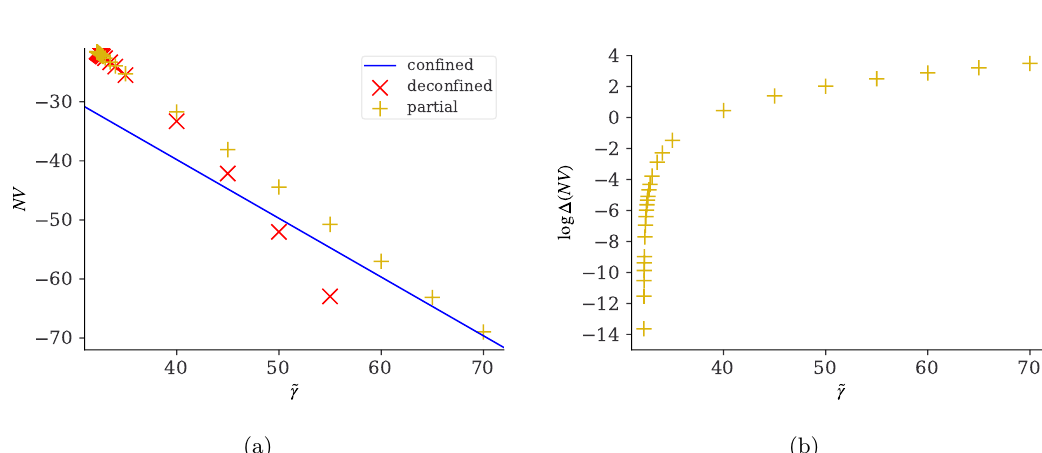
Figure 9. (a) θ = π numerical results for the | M j | versus j for N = 30 in the partial phase, for ˜ γ = 45 (red crosses) and 70 (black 3-point stars). Notice that | M 0 | is small but non-zero. (b) Using eq. (2.23), with g 2 = 0 . 1 , we converted the results of (a) into the Polyakov loop eigenvalue distribu- tion 2 πρ ( φ j ) =